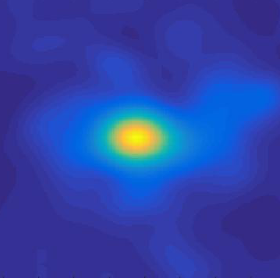
Figure 9. Response map after background